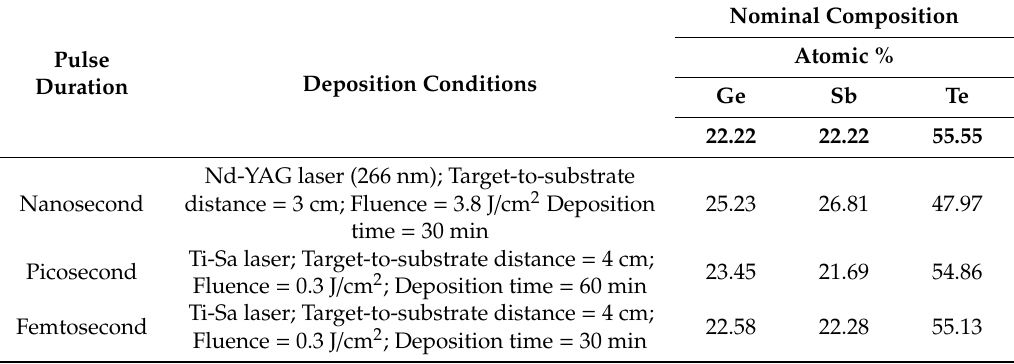
Table 2. Representative concentrations for Ge, Sb, and Te of three Ge 2 Sb 2 Te 5 thin films deposited in di ff erent temporal regimes.